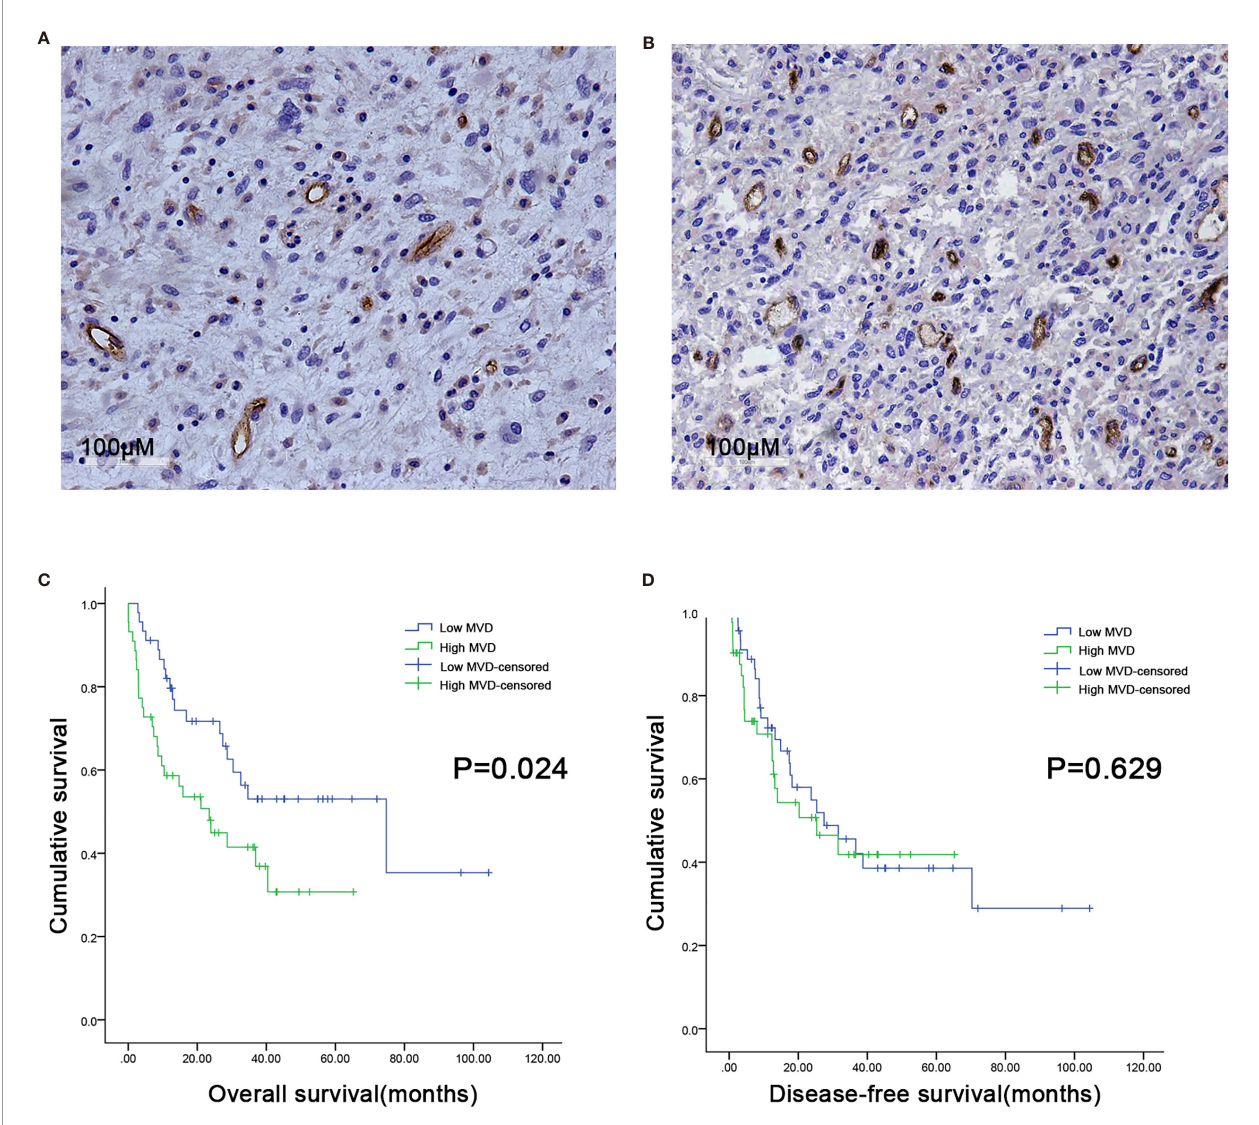
FIGURE 1 | Microvessel distribution in retroperitoneal liposarcoma tissues. (A) Representative images of RLPS tissues with low MVD. There are seven microvessels in the fi eld. MVD = 21.9/mm 2 . (B) Representative images of RLPS tissues with high MVD. There are 37 microvessels in the fi eld. MVD = 113.8/mm 2 . ×200 magni fi